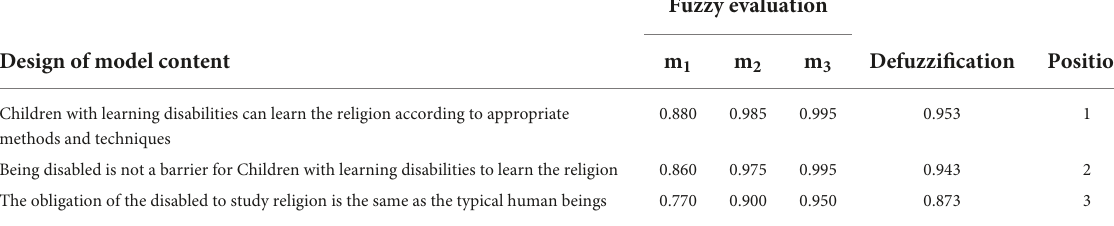
TABLE 5 Fuzzy evaluation on construct one: The rights to learn for children with learning disabilities.